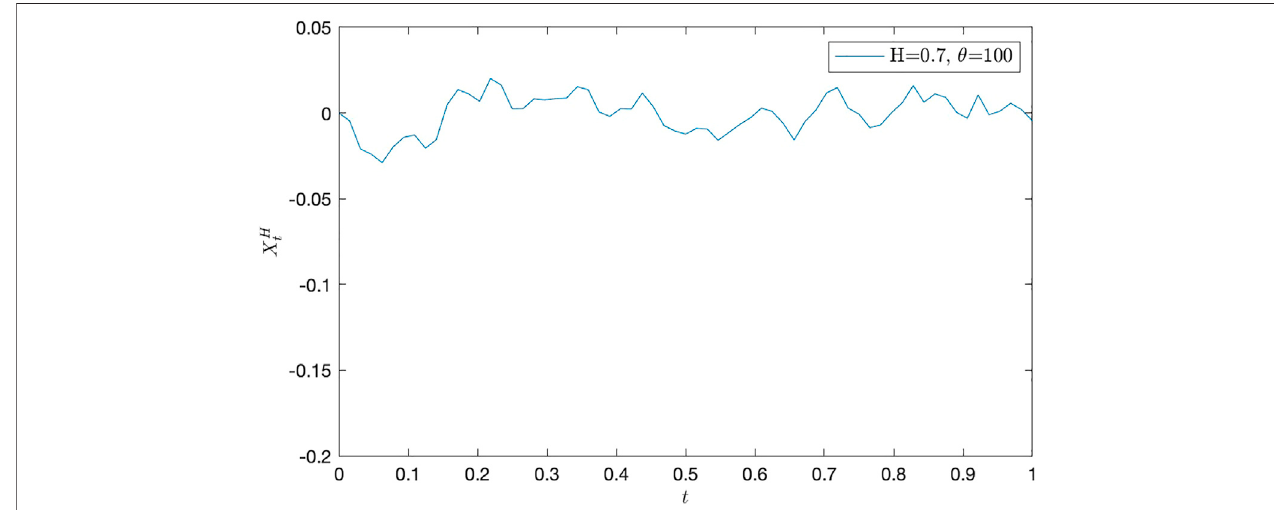
FIGURE 3 | Path of X H with θ (cid:1) 100 and H (cid:1) 0.7.